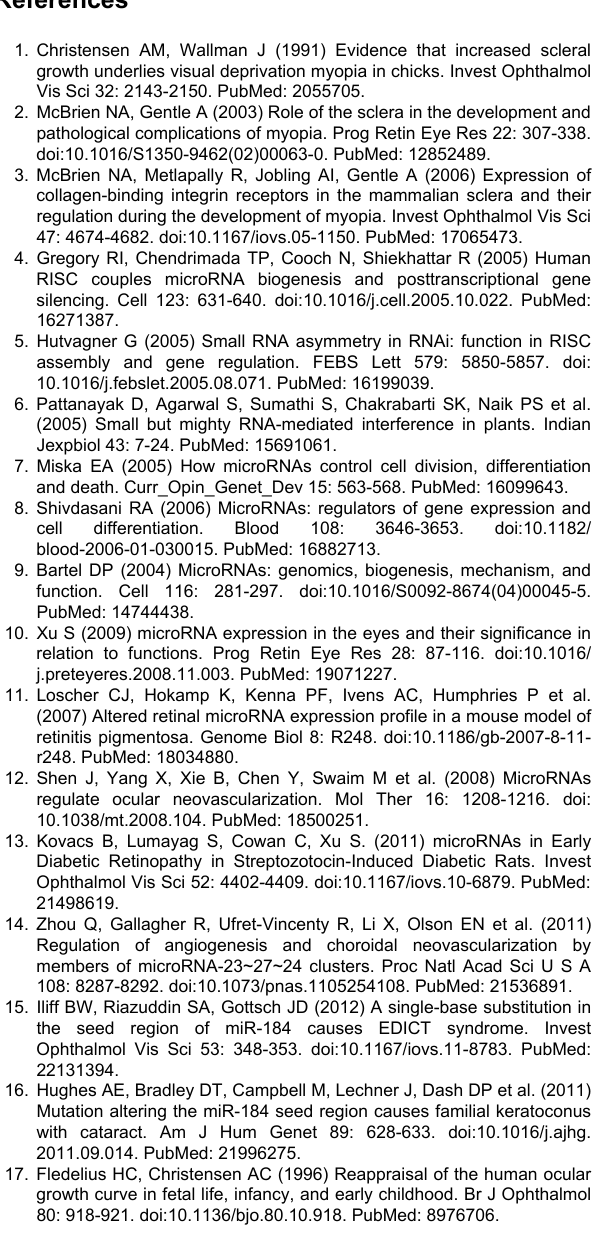
(XLSX) Figure S1. Pearson correlation.